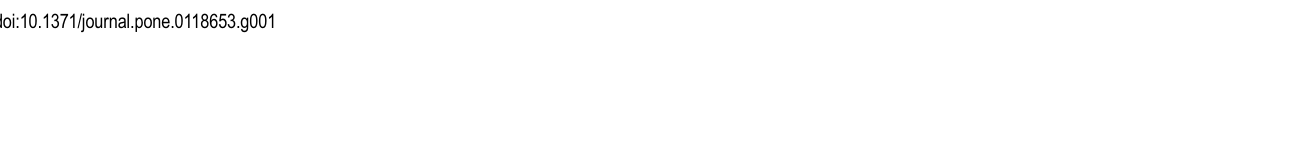
PLOS ONE | DOI:10.1371/journal.pone.0118653 February 17,